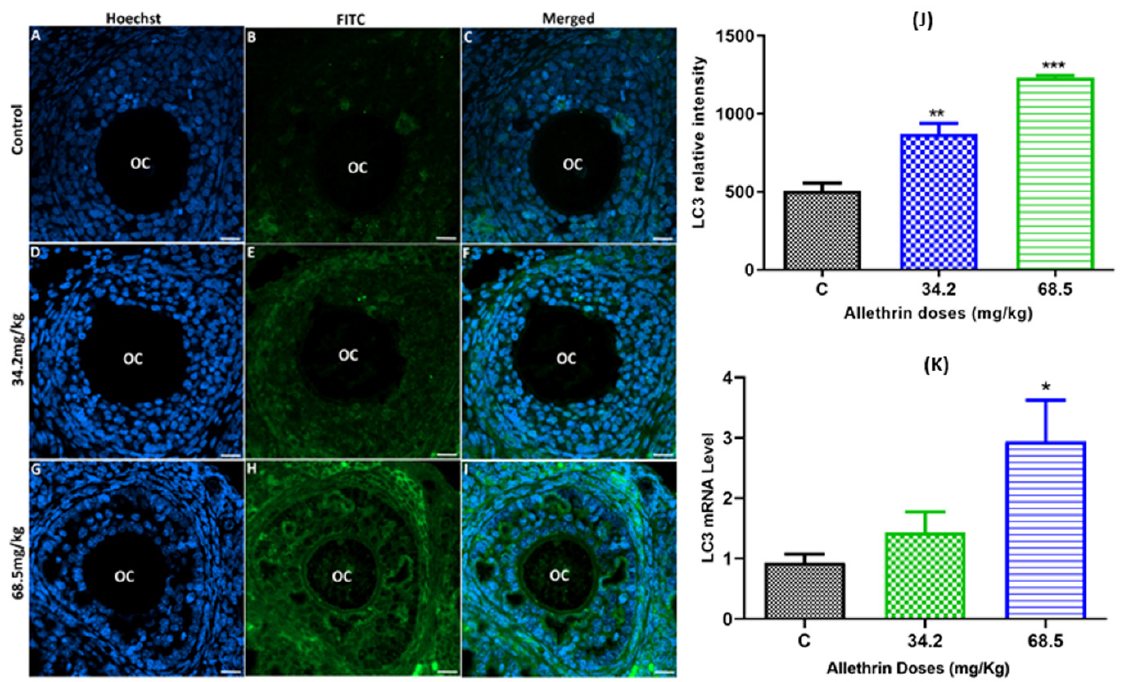
Figure 3. Autophagy in ovarian tissue was evaluated by immunofluorescence staining ( A–I ) and assessment of the relative fluorescence intensity ( J ) of LC-3 in the control and exposed groups. Additionally, the mRNA levels of the LC-3 gene in female rats exposed to allethrin compared with those in the control rats were determined by RT–PCR ( K ). Scale bar = 200 μ m. * p < 0.05; ** p < 0.005; *** p < 0.0001.